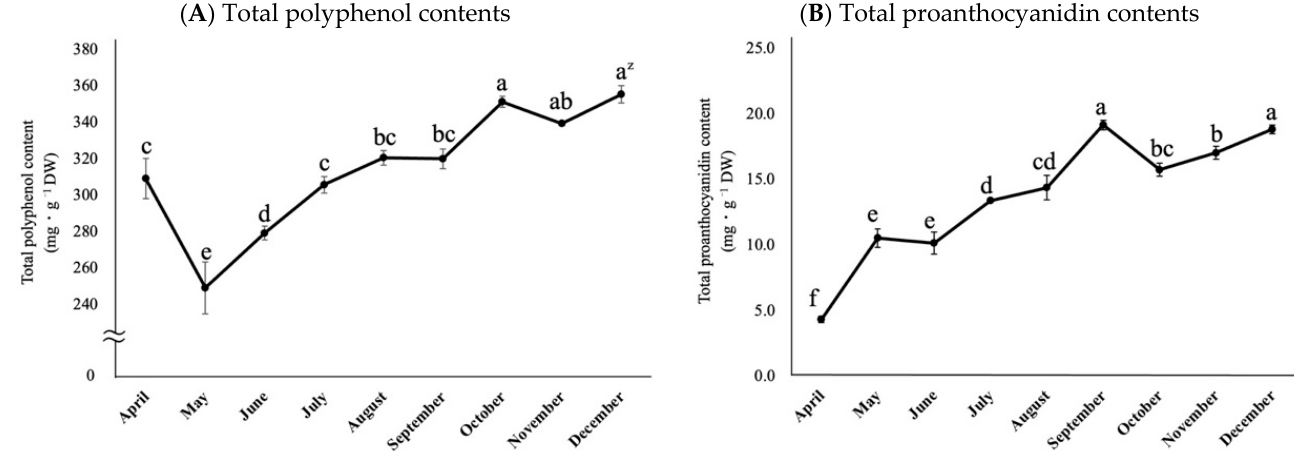
Figure 5. Seasonal changes in the polyphenol content ( A ) and polyphenol content ( B ) in mature leaves of rabbiteye blueberry Homebell. z Different letters among months represent significant dif- ferences at 5% level as determined by Tukey’s multiple range test (n = 3).